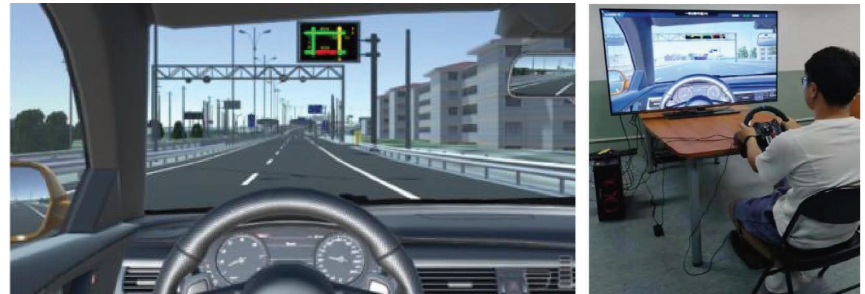
Figure 8: Dynamic simulation experiment environment.